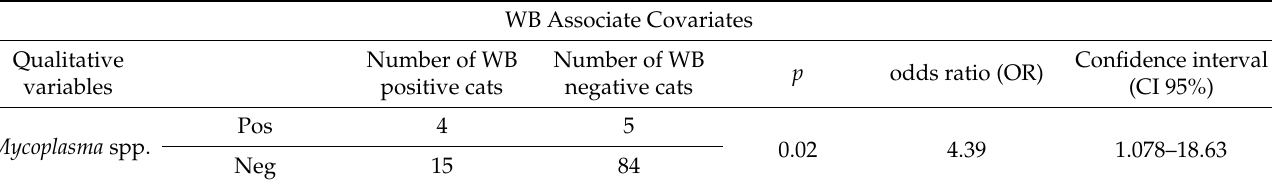
Table 2. L. infantum PCR results were found to be significantly associated with Feline Immunodeficiency Virus (FIV) infection, with higher values of Blood Urea Nitrogen (BUN) and Neutrophils (NEUTR), and with low values of Hematocrit (HCT), Red blood cells (RBC), and Hemoglobin (Hb). Western blot (WB) positivity was instead positively associated with concurrent Mycoplasma spp. infection. The data of each covariate are summarized in the